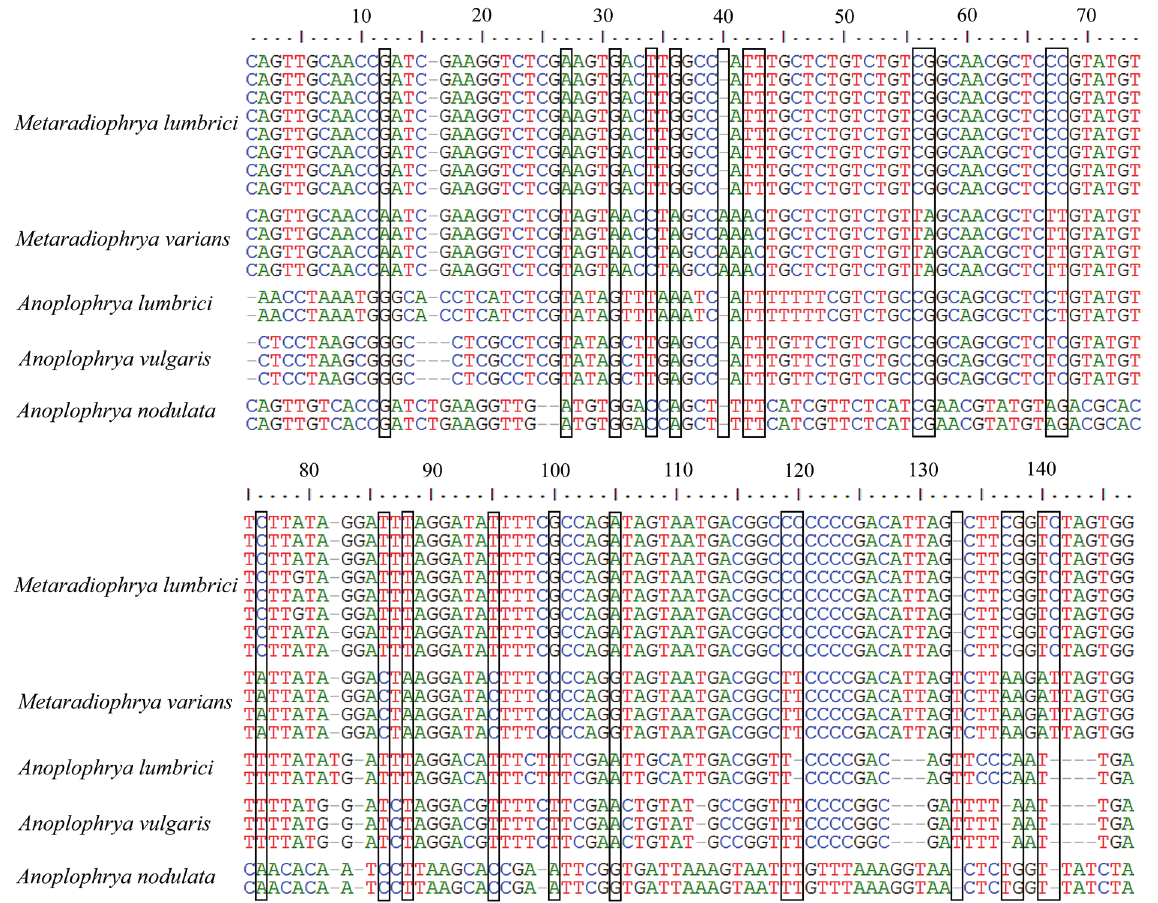
Fig. 16. Alignment of variable positions of the 18S rRNA gene of five astome ciliates isolated from the lumbricid earthworms. Boxes mark 25 nucleotide positions in which M. lumbrici (Dujardin, 1841) differs from M. varians (de Puytorac, 1954). The comparison with three outgroup species of Anoplophrya Stein, 1860 indicates that 19 out of the 25 variable nucleotide positions of M. lumrici are either plesiomorphies or possibly